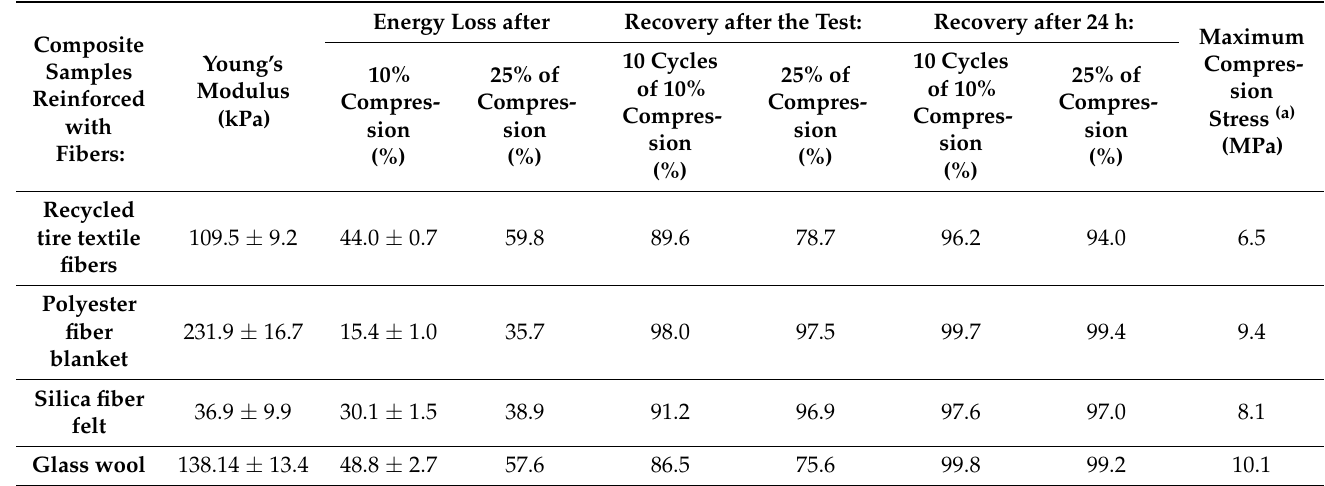
Table 2. Mechanical properties of the new fiber-reinforced rubber-silica